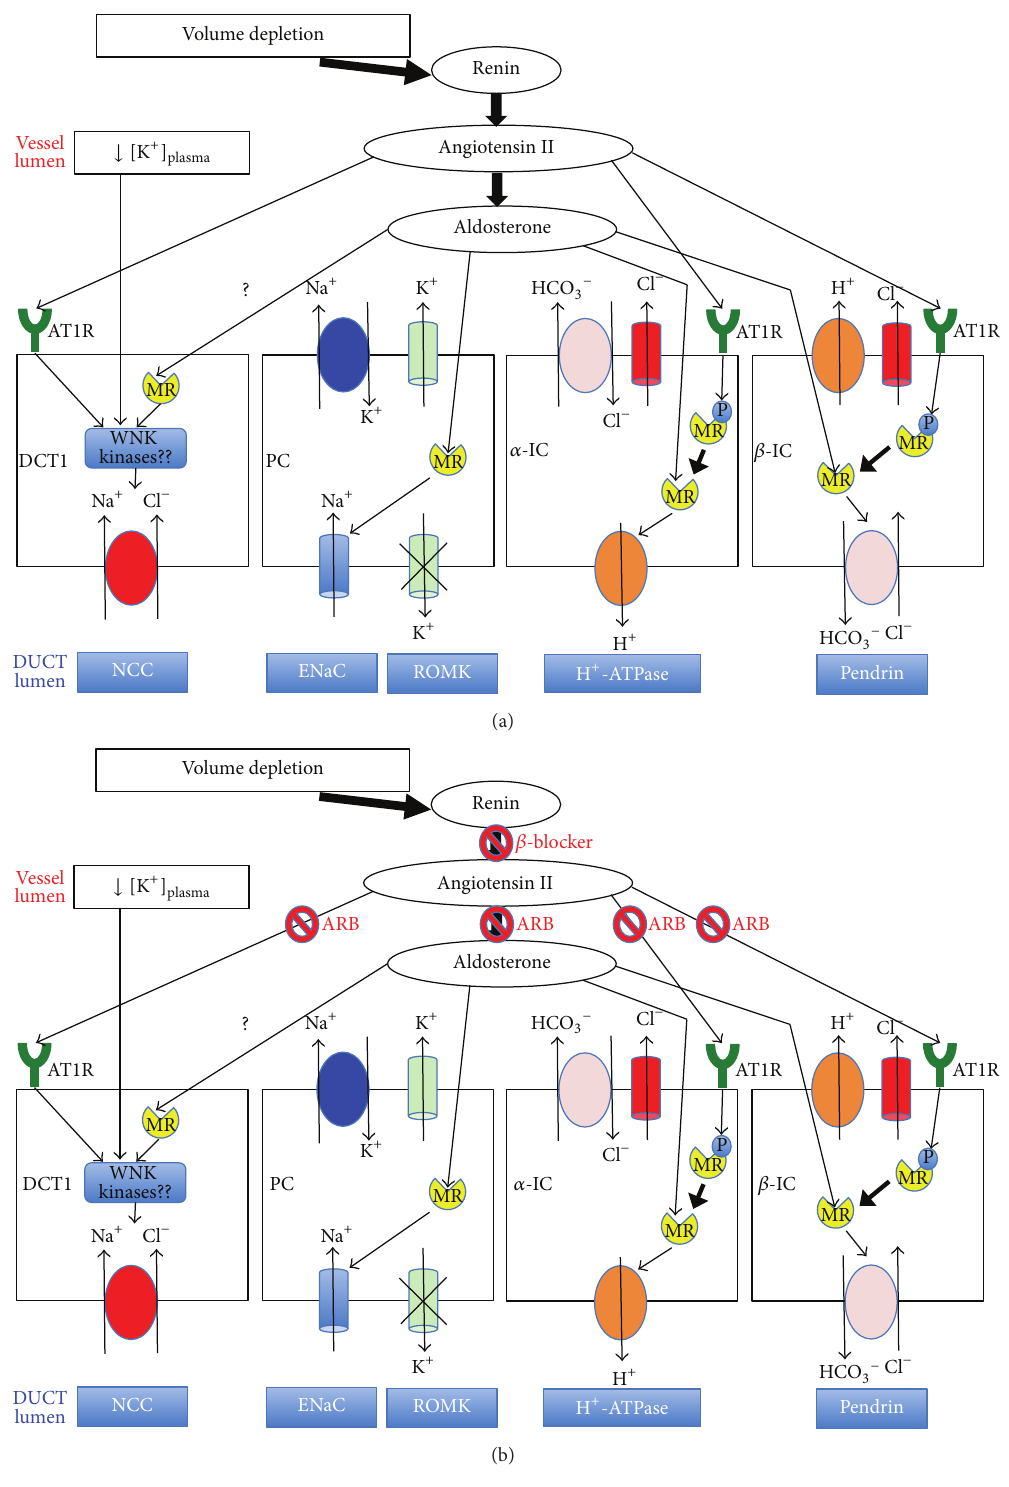
Figure 2: (a) Angiotensin II and aldosterone response in volume depletion and hypokalemia. (b) Angiotensin II and aldosterone response are affected by both an angiotensin II type 1 receptor blocker and a 𝛽 -adrenoreceptor antagonist. 𝛼 -IC, 𝛼 -intercalated cell; ARB, angiotensin II type 1 receptor blocker; AT1R, angiotensin II type 1 receptor; 𝛽 -blocker, 𝛽 -adrenoreceptor antagonist; 𝛽 -IC, 𝛽 -intercalated cell; DCT1, initial part of the distal convoluted tubules; ENaC, amiloride-sensitive sodium channel; MR, mineralocorticoid receptor; NCC, thiazide-sensitive NaCl cotransporter; P, phosphorylated; PC, principal cell; ROMK, renal outer medullary potassium channel; WNK, with-no-lysine